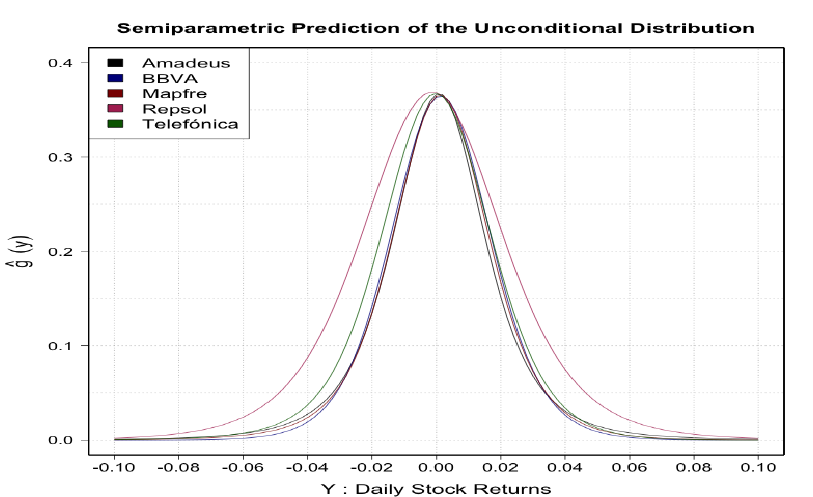
Figure 5. Unconditional densities of stock returns obtained from integrating the conditional ones over all observed IBEX35